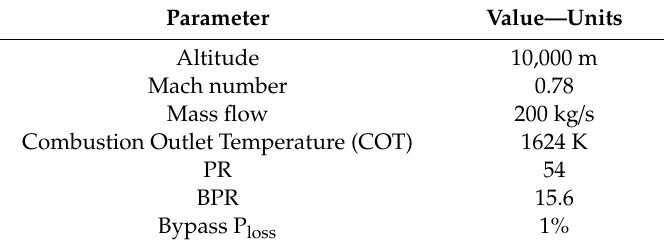
Table 4. Design engine parameters at cruise